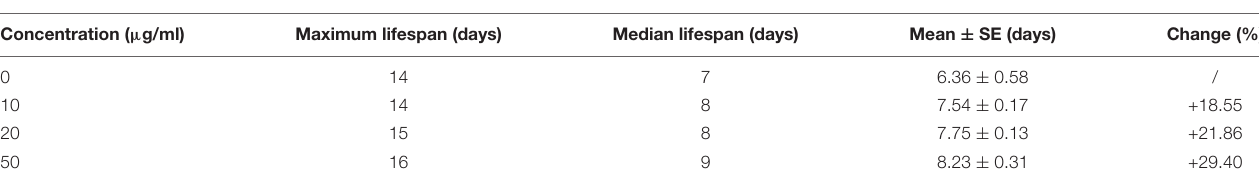
TABLE 1 | Effects of TFH on C. elegans (N2) longevity.